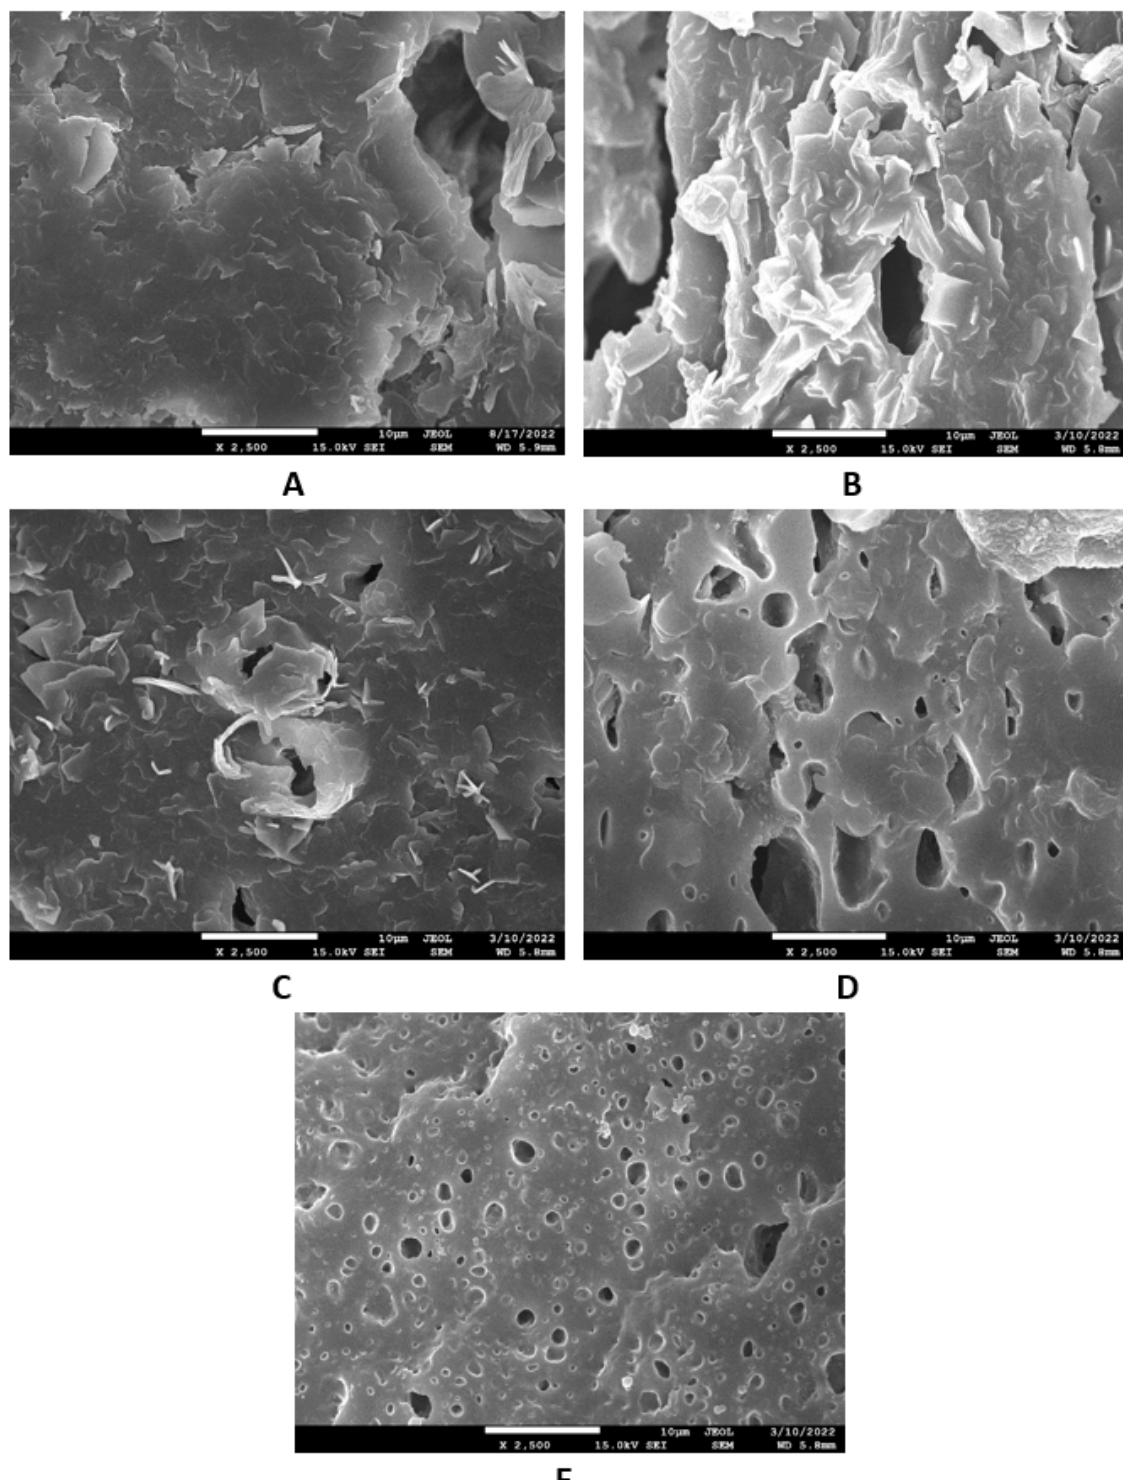
Figure 17. SEM images of vulcanizates based on SBR after washing in boiling water: ( A ) reference vulcanizate without glycerol, ( B ) vulcanizate with 5 phr of glycerol, ( C ) vulcanizate with 10 phr of glycerol, ( D ) vulcanizate with 15 phr of glycerol, and ( E ) vulcanizate with 20 phr of glycerol.